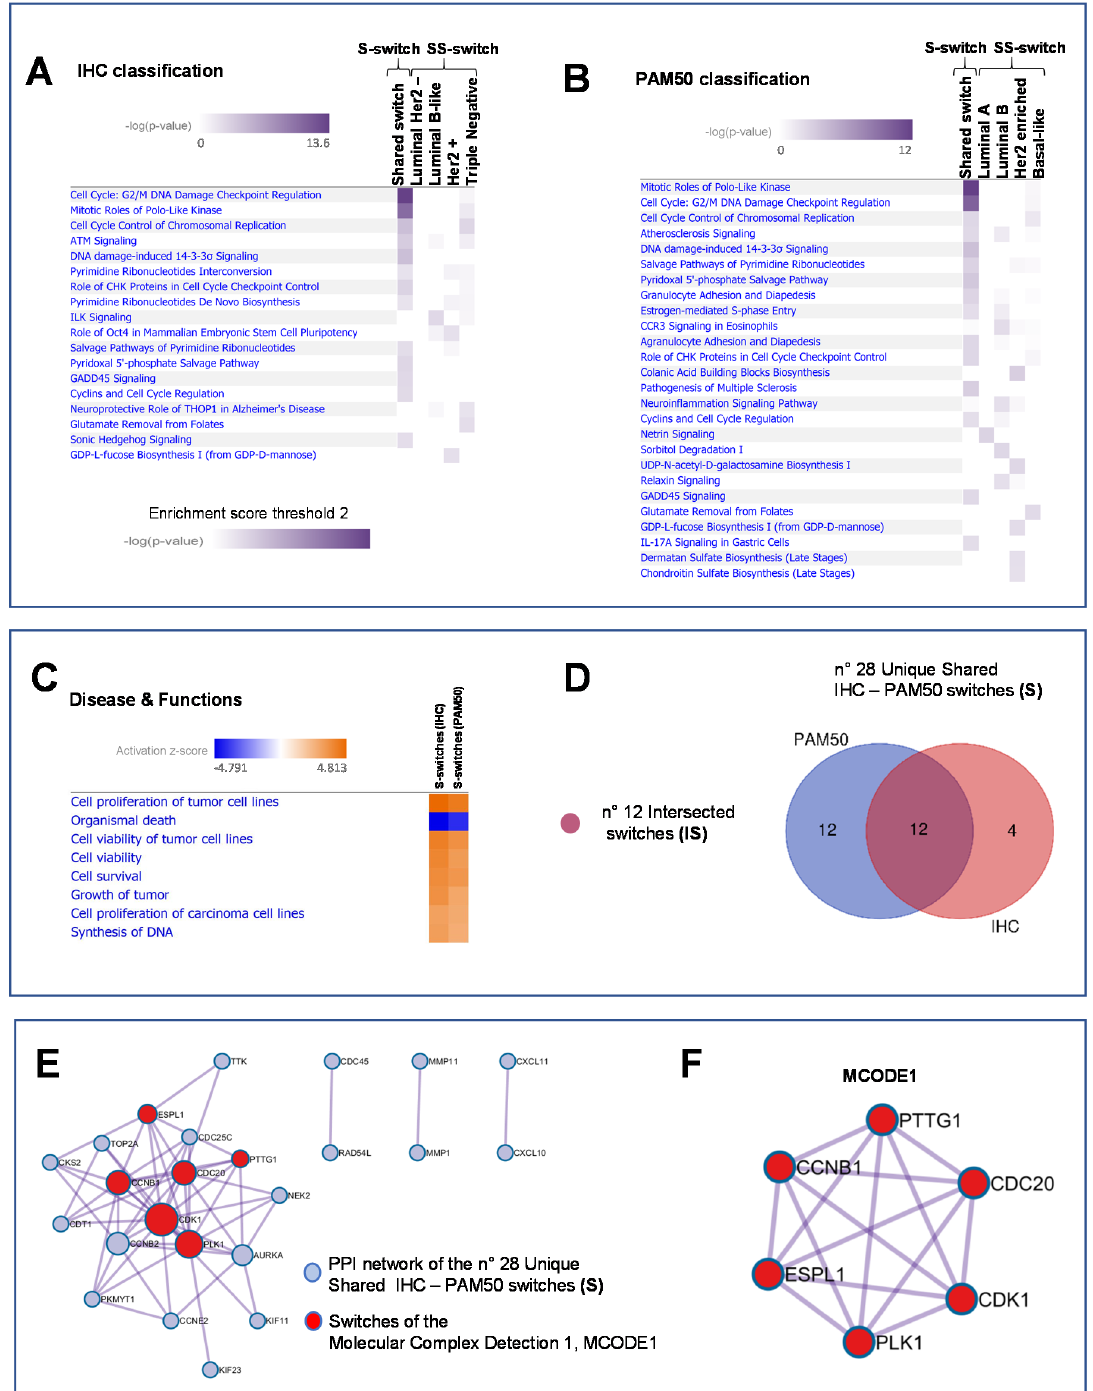
Figure 4. Integration and prediction of IHC and PAM50 key regulatory switches. ( A ) and ( B ) Heatmaps of the enriched pathways for IHC and PAM50 classification, respectively. Enrichment score (Fisher’s Exact right-tailed test, p -value < 0.01). ( C ) Prediction of inhibited (blue squares) and activated (orange squares) functions of shared IHC and PAM50 switches sorted by activation Z-score (absolute value 3). ( D ) Venn diagram defining the Intersected Shared (IS) switches of shared IHC and PAM50 switches. ( E ) Protein–protein interaction (PPI) network of the 28 Unique Shared IHC–PAM50 switches resulted in 24 PPI network molecules. ( F ) MCODE1 represents a densely connected protein complex (6 in red out of 24) of the PPI network by the Molecular Complex Detection algorithm.